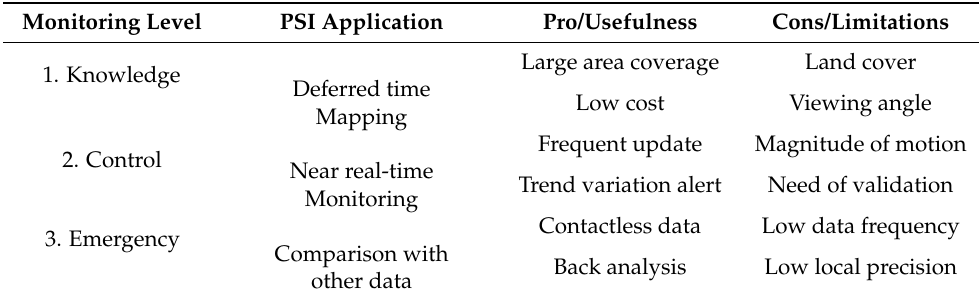
Table 2. Scheme of the pro and cons of Multi-Temporal Satellite Interferometry (MTInSAR) applica- bility at each monitoring